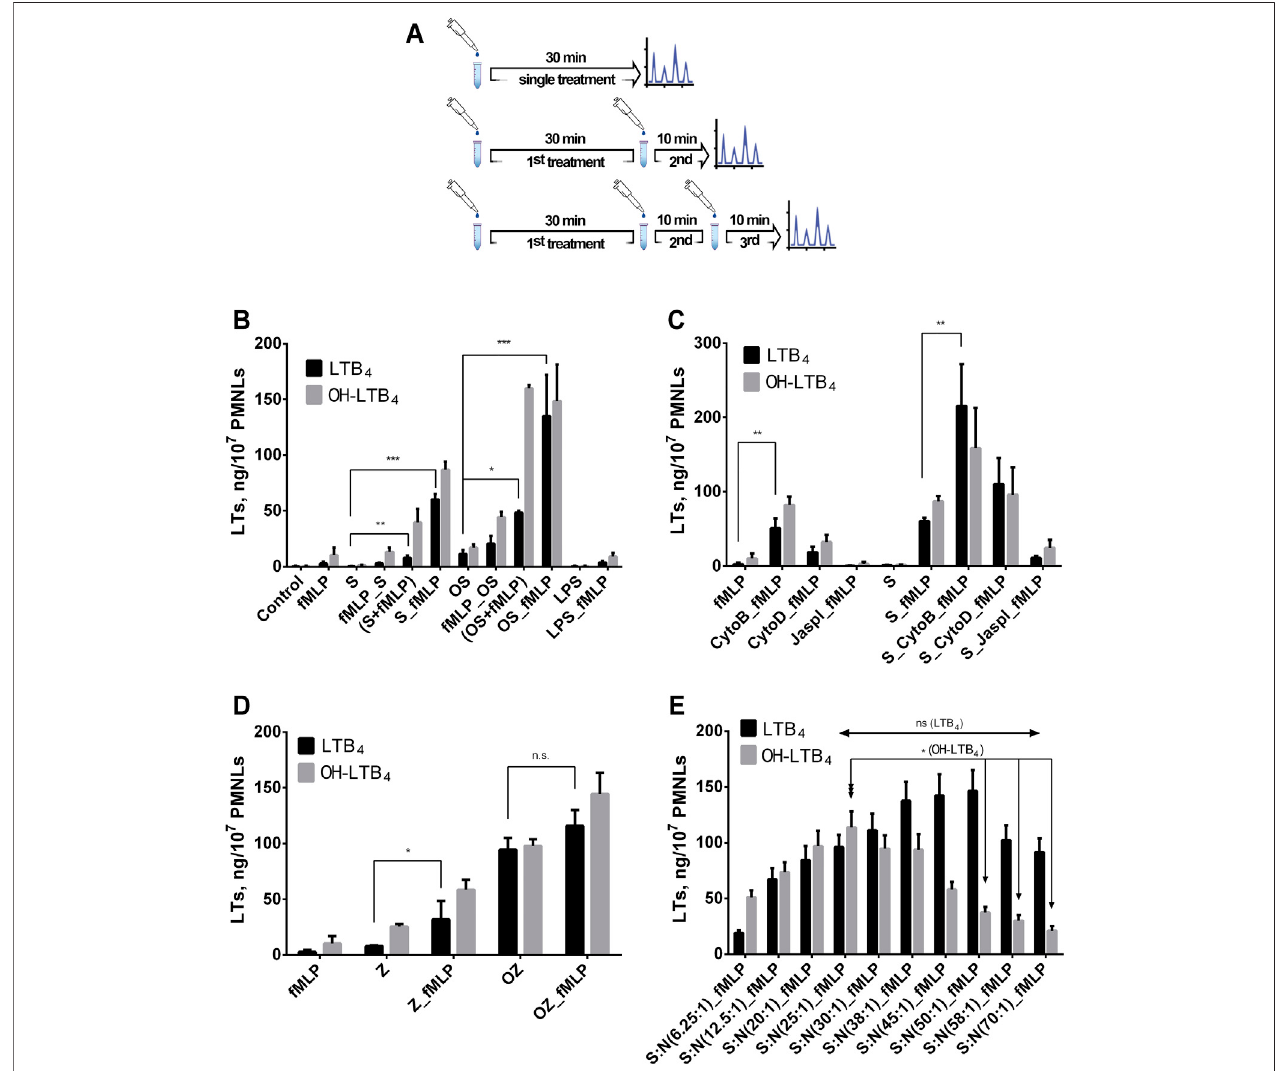
FIGURE 1 | Effect of Salmonella typhimurium or zymosan on fMLP-induced leukotriene synthesis in human neutrophils. Before treatment, PMNLs (0.9 – 1.0) x10 7 / 6 ml were pre-incubated for 10 min at 37 ° C, 5% CO 2 . (A) Timing options for treatments are presented. (B,C) — (the ratio of bacteria:PMNLs ∼ 25:1). (B) At single treatment, control (no additives), or fMLP (0.1 µM), or S/OS, or bacteria plus fMLP (S/OS + fMLP), or LPS (2 μ g/ml) were added for 30 min. At complex treatment, bacteria,orfMLP,orLPSwereaddedas fi rststimulusandS,OSorfMLPasthesecond.Hereinafter,onthe X -axis,sequentialstimuliarelabeled,listed intheorder ofadditionandseparatedbyanunderscore.Valuespresentmean ± SEMof fi veindependentexperimentsperformedinduplicate. (D) Atsingletreatment,fMLP(0.1 µM), or Z/OZ (0.4 mg/ml) were added for 30 min. At complex treatment, Z/OZ (0.4 mg/ml) were added as the fi rst stimulus, and then fMLP (0.1 µM) as the second, as indicated. Values indicate mean ± SEM of three independent experiments performed in duplicate. (C) At single treatment, fMLP (0.1 µM), or S were added for 30min. At complex treatment, no additives (left panel) or bacteria (right panel) were added for 30 min, then a second stimulation was performed with Cyto B (5 µM) or Cyto D (10 µM) or Jaspl (0.5 µM) followed by the third treatment with fMLP (0.1 µM) as indicated. Values indicate mean ± SEM of fi ve independent experiments performed in duplicate. (E) Leukotriene synthesis in human neutrophils exposed to Salmonella typhimurium ( fi rst treatment) followed by fMLP (0.1 µM) addition for 10 min, at various bacterialload.Theratioofbacteria(S):PMNLs(N)isindicated.Valuespresentmean ± SEMof fi veindependentexperimentsperformedinduplicate.The5-LOXproducts were analyzed using HPLC, and data for LTB 4 and ω -OH-LTB 4 are presented. * p < 0.05, ** p < 0.01, *** p < 0.001 for pairs of data compared as indicated by two-way ANOVA followed by Tukey ’ s multiple comparison